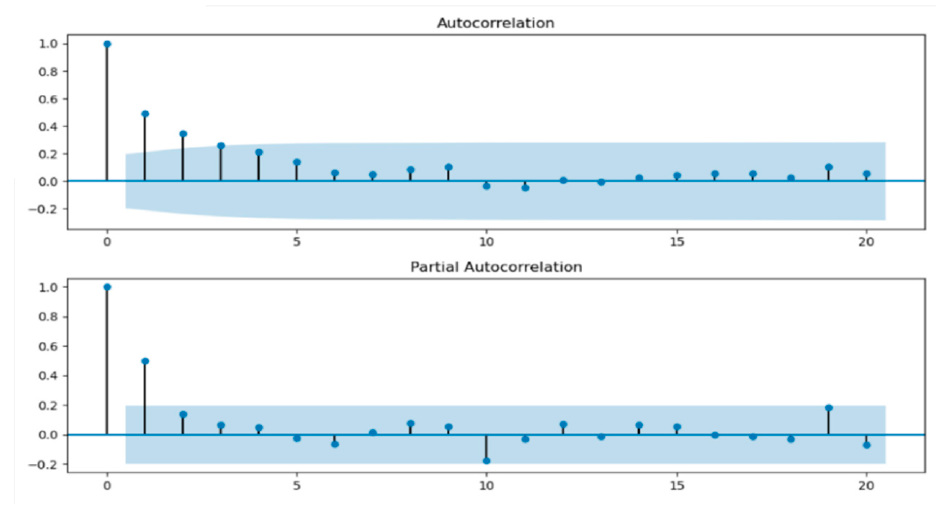
Figure 4. The visualization of ACF and PACF .